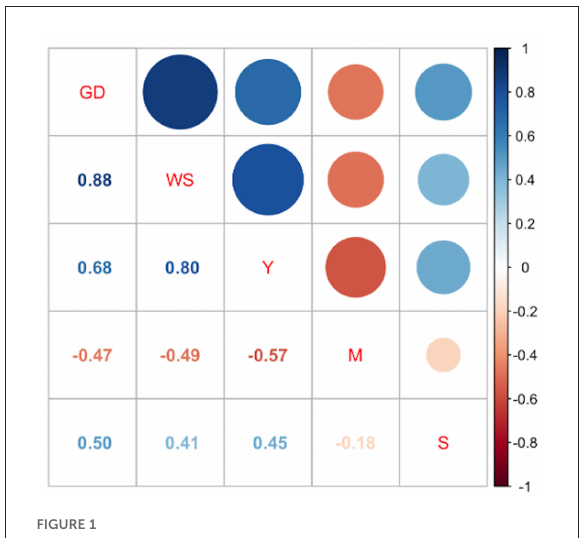
FIGURE1 Spearman correlation analysis between quantitative variables. Footnote: GD grain diameter, WS weight of 1,000 seeds, Y yield, M days to physiological maturity, S concentration of triterpene